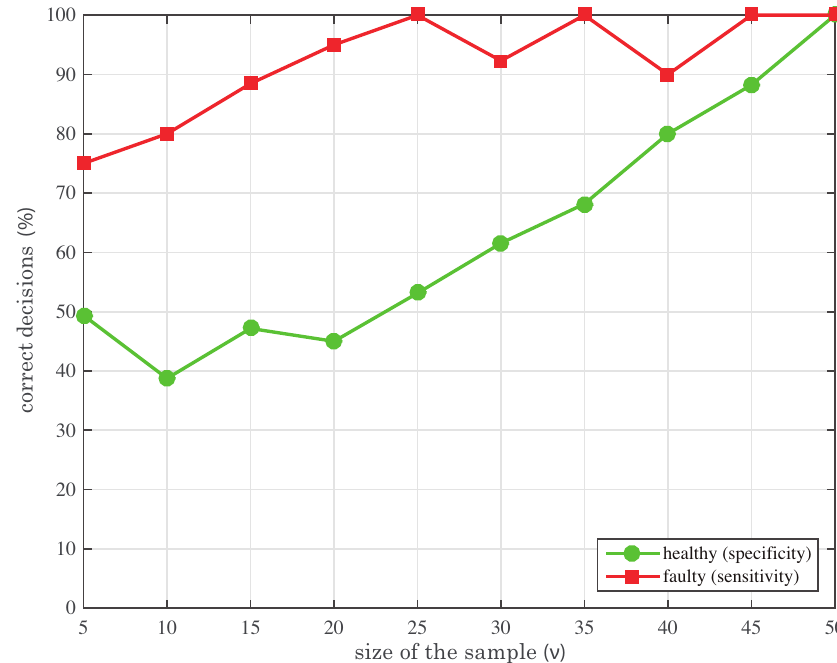
Figure 3. Specificity ( green ) and sensitivity ( red ) of the test as a function of the size of the sample ( ν ), that is, the number of rows of matrix Y in Equation (8), when the first score is used. As can be seen in Figure 3, the sensitivity and specificity change drastically when varying ν